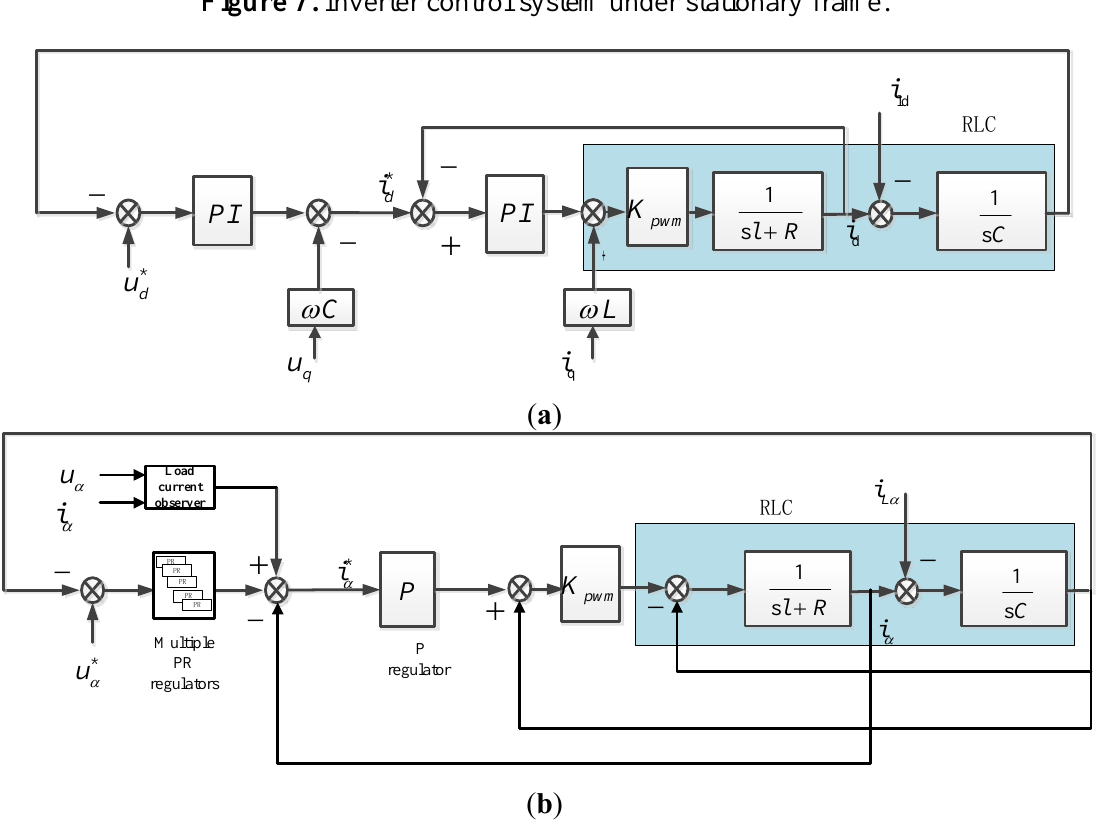
Figure 8. Structure of controllers. ( a ) Traditional inverter controller; ( b ) The proposed inverter controller with